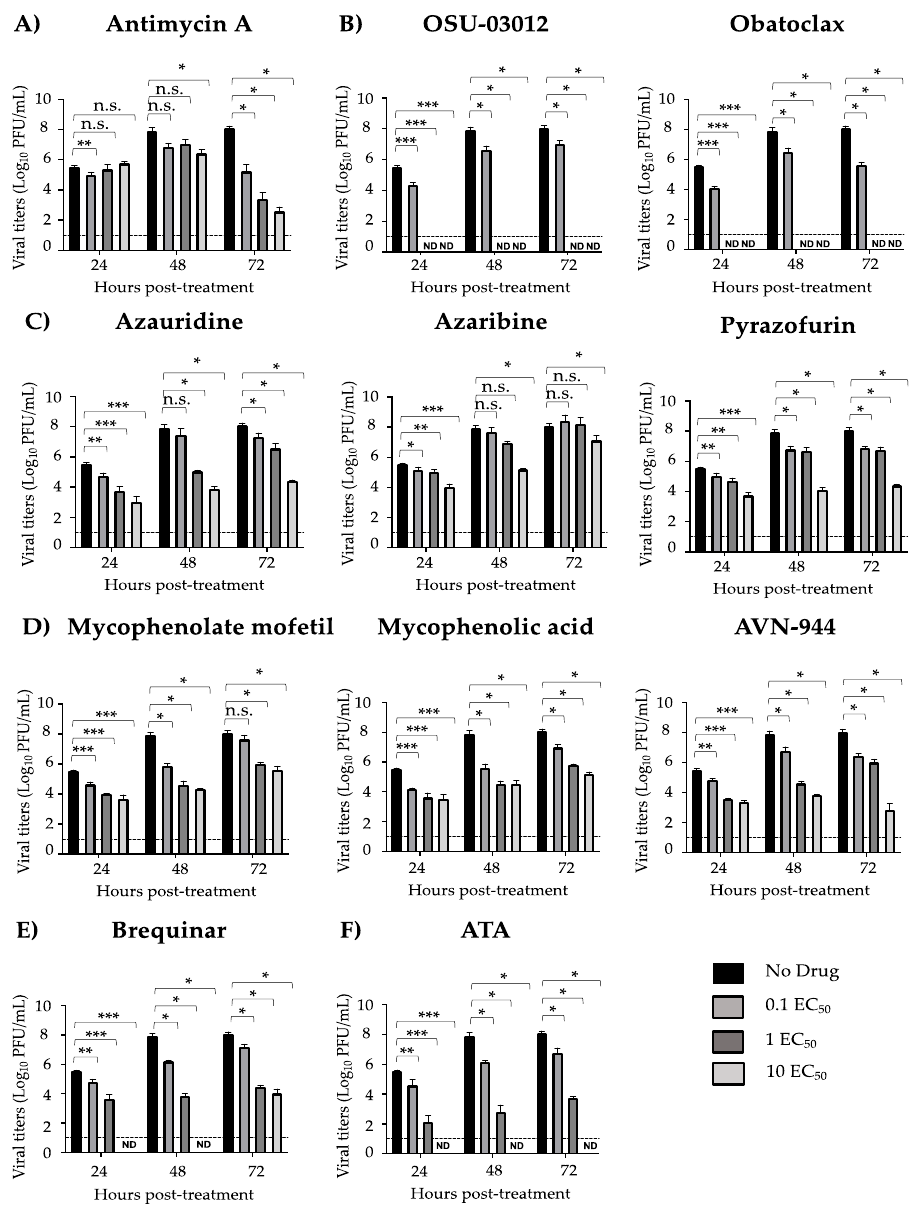
Figure 4. Growth kinetics inhibition of ZIKV Paraiba/2015: Vero cells (24-well plate format, 2.5x10 5 cells/well, triplicates) were infected (MOI 0.1) with Paraiba/2015. After 2 h viral absorption, cells were treated with the indicated concentrations of compounds (0, 0.1, 1, and 10 EC 50 ) ( A ) Antimycin A, ( B ) OSU-03012 and Obatoclax, ( C ) Azaribine, Azauridine, and Pyrazofurin, ( D ) Mycophenolate mofetil, Mycophenolic acid, and AVN-944, ( E ) Brequinar, and ( F ) Aurintricarboxylic acid (ATA); or 0.1% DMSO vehicle control (No drug) in infection media (DMEM 2% FBS). Tissue culture supernatants were collected at 24, 48, and 72 h post-treatment, and viral titers were calculated by immunostaining using the anti-E 4G2 mAb. Dotted line indicates the limit of detection (10 PFU). Data were expressed